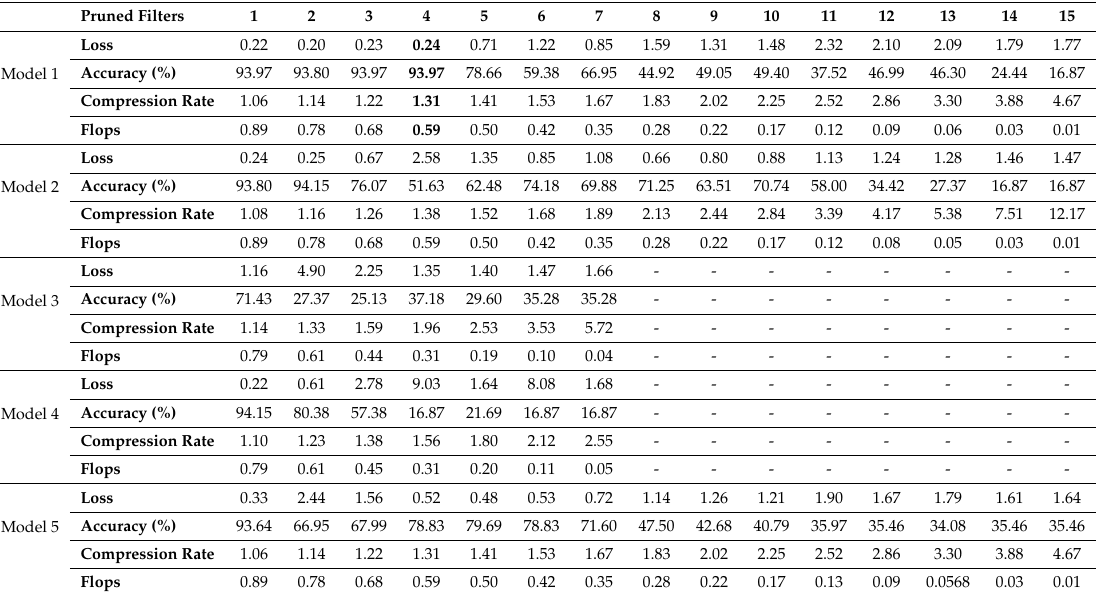
Table 6. Results for filter pruning with no retraining.